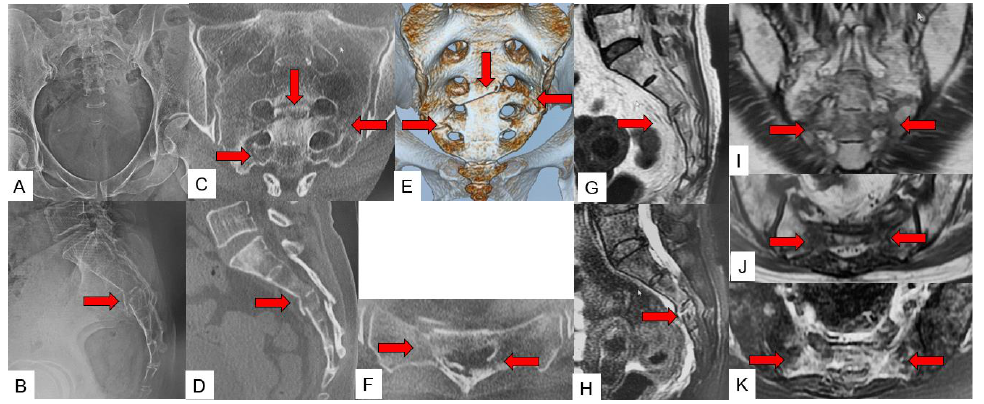
Figure 8. 57-year-old woman, H/U-type fracture of SIF. ( A ): Anteroposterior radiograph, ( B ): Lateral radiograph, ( C ): Coronal CT, ( D ): Sagittal CT, ( E ): 3D CT, ( F ): Axial CT, ( G ): Sagittal T1-weighted MR image, ( H ): Sagittal fat-suppressed T2-weighted MR image, ( I ): Coronal T1-weighted MR image, ( J ): Axial T1-weighted MR image, ( K ): Axial fat-suppressed T2-weighted MR image, red arrows indicate fracture line. Case 3: 89-year-old woman, unilateral vertical-type fracture of SIF (Figure 9).